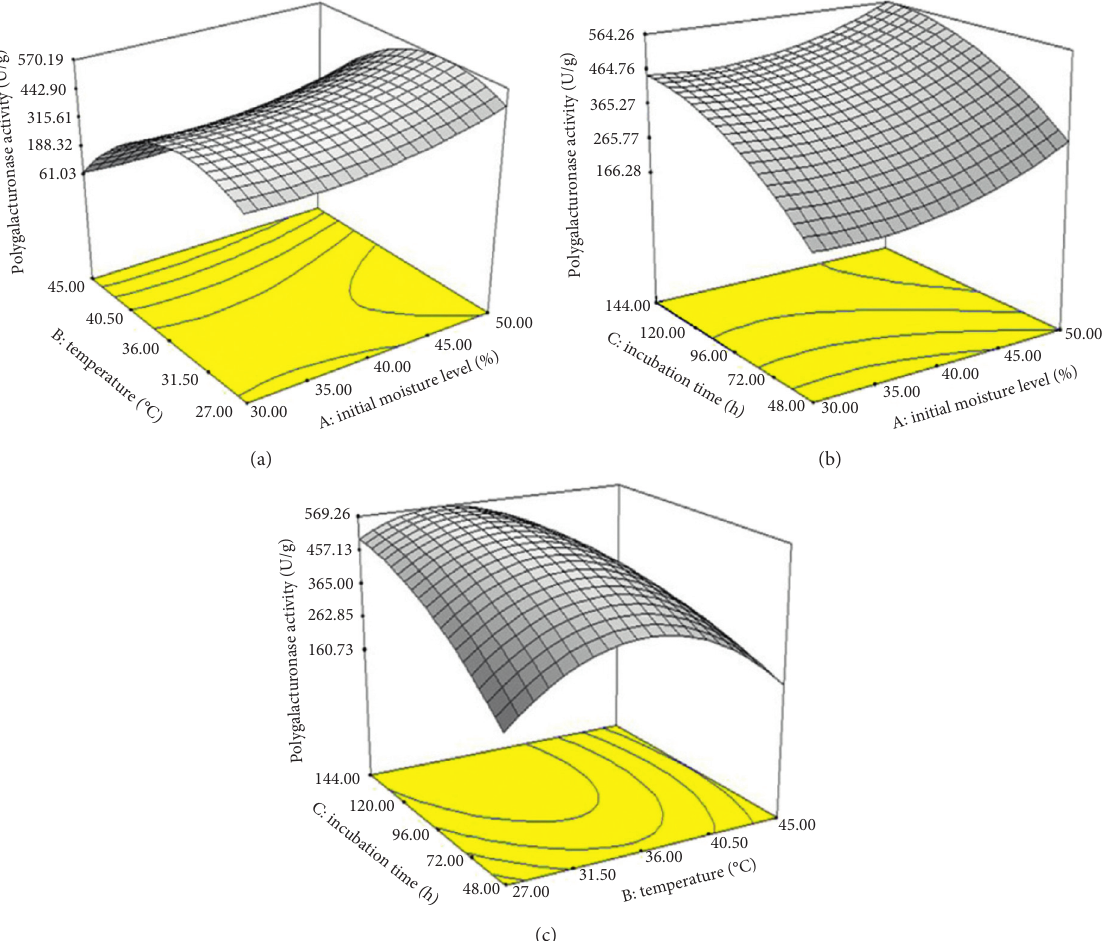
Figure 15: Response surface plot on the effect of (a) initial moisture level vs. temperature, (b) initial moisture level vs. incubation time, and (c) temperature vs. incubation time